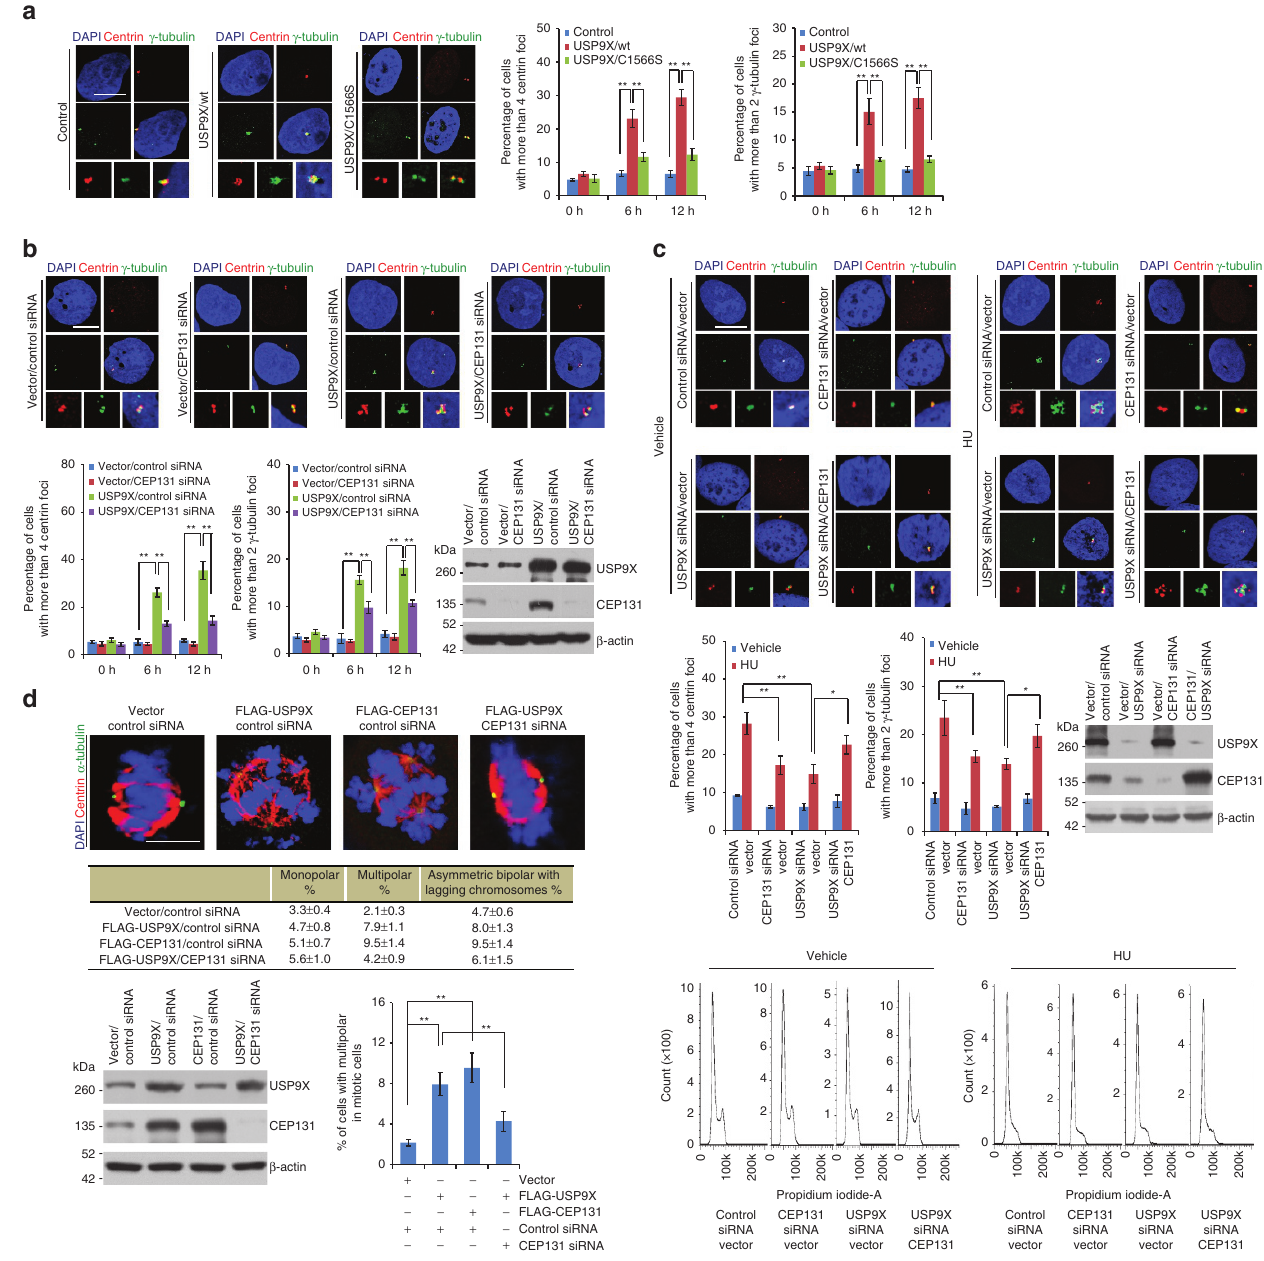
Figure 5 | USP9X-promoted CEP131 stabilization regulates centrosome amplification and chromosome stability. ( a ) Control U2OS cells and cells with Dox-inducible expression of USP9X/wt or USP9X/C1566S in the presence of Dox were synchronized with double-thymidine block and released followed by immunostaining with antibodies against the indicated proteins (left panel). Scale bar, 10 m m. Population of cells with the indicated numbers of foci at different time points were counted (right panel). Each bar represents the mean ± s.d. for biological triplicate experiments. ** P o 0.01, one-way ANOVA. ( b ) U2OS cells stably expressing USP9X were transfected with indicated siRNAs. The cells were synchronized with double-thymidine block and released followed by immunostaining with antibodies against the indicated proteins (upper panel). Scale bar, 10 m m. Population of cells with the indicated numbers of foci at different time points were counted (lower left panel). Each bar represents the mean ± s.d. for biological triplicate experiments. ** P o 0.01, one-way ANOVA. The expression of indicated proteins was examined by western blotting (lower right panel). ( c ) U2OS cells transfected with indicated siRNAs or genes were treated with HU, followed by analysis of centrosome numbers with immunostaining (upper panel). Scale bar, 10 m m. Population of cells with the indicated numbers of foci were counted. Each bar represents the mean ± s.d. for biological triplicate experiments (middle left panel). * P o 0.05; ** P o 0.01, one-way ANOVA. The expression of USP9X and CEP131 from cells with HU treatment was examined by western blotting (middle right panel). Cell cycle profiles were determined by FACS (lower panel). ( d ) MCF-7 Cells stably expressing USP9X or CEP131 were transfected with indicated siRNAs and synchronized with double-thymidine block. Cells were collected after 12h of release and stained (upper panel). Scale bar, 10 m m. Percentage of cells with different chromosomal instability phenotypes in mitosis was calculated and shown (middle panel). Percentage of cells with multipolar mitotic phenotype was analysed (lower panel). Each bar represents the mean ± s.d. for biological triplicate experiments. ** P o 0.01, one-way ANOVA. The expression of indicated proteins was examined by western blotting (lower